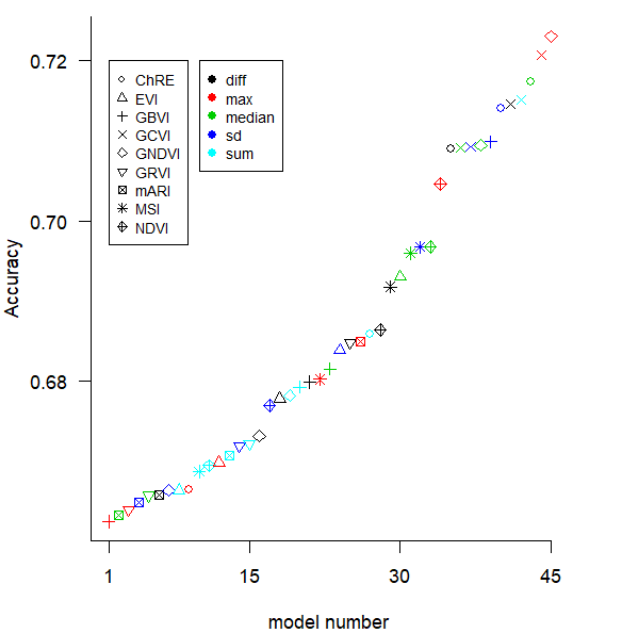
Figure A3. Accuracy for full-field, two-variable linear regression models by predictor variable. The colors represent the aggregation type of the vegetation index (the sum, median, standard deviation = sd, maximum=max, or difference between minimum and maximum = diff) for each vegetation